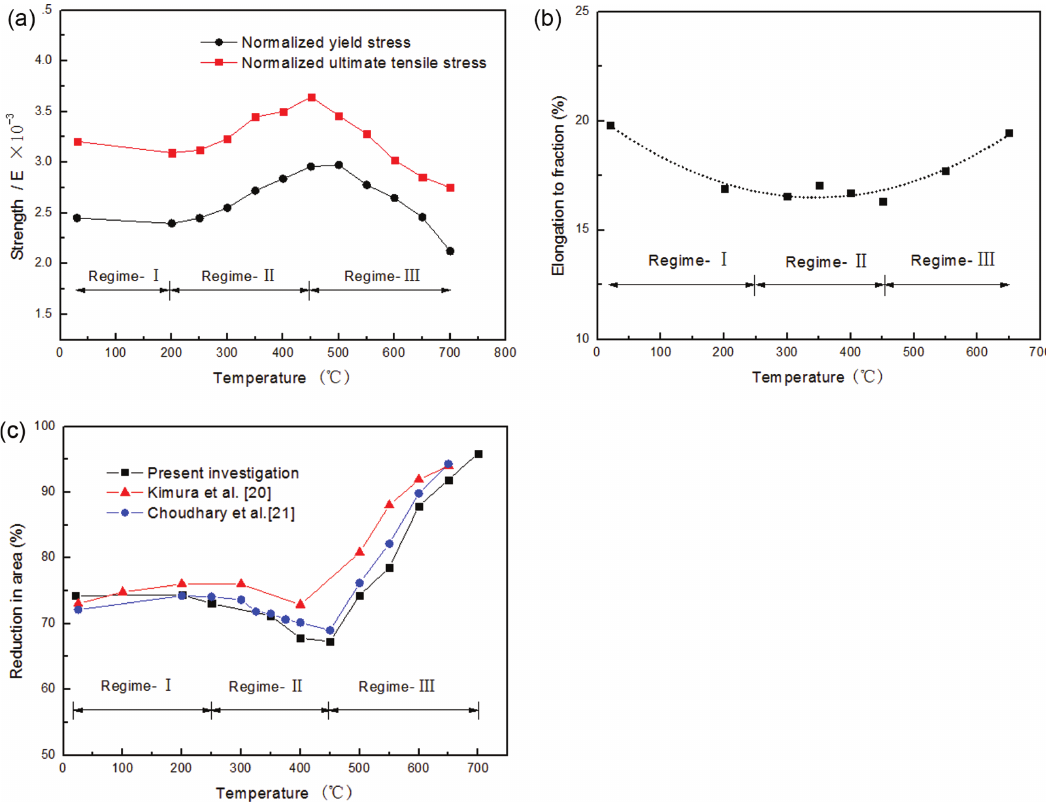
Figure 6: Variations of tensile properties with temperature: (a) normalized yield stress and normalized ultimate tensile stress; (b) elongation; (c) reduction in